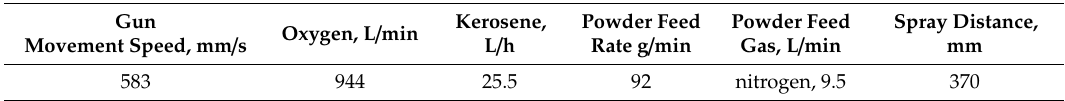
Table 3. High Velocity Oxy-Fuel (HVOF) spraying